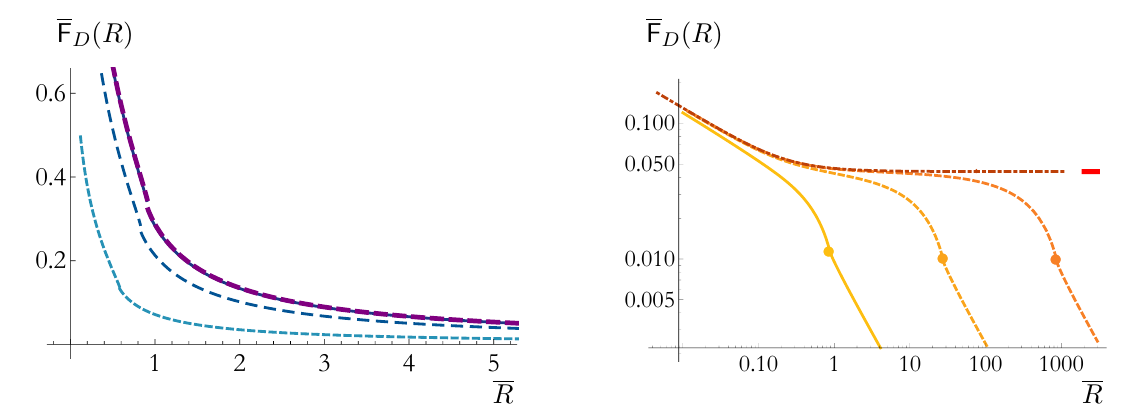
Figure 11. (Right) Function F D from the entanglement entropy of a disk as a function of its radius R . Dots stand for the transition of the embedding, namely those represented in figure 7(a) to 7(b). (Left) Same quantities in linear scale as we approach the confining theory. In both cases, when the transition happens, there is a visible change in the behavior of the curves. This signals the proximity of the IR gapped phase. See legends in figure 10.